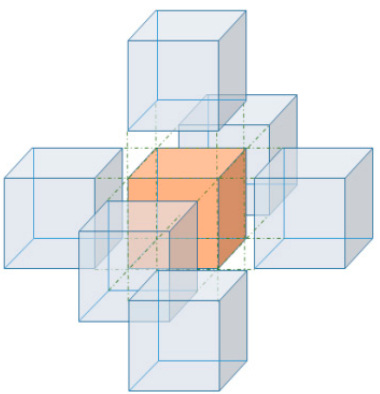
Figure 3. The tier system with the six cells in surface contact with the focal cell.